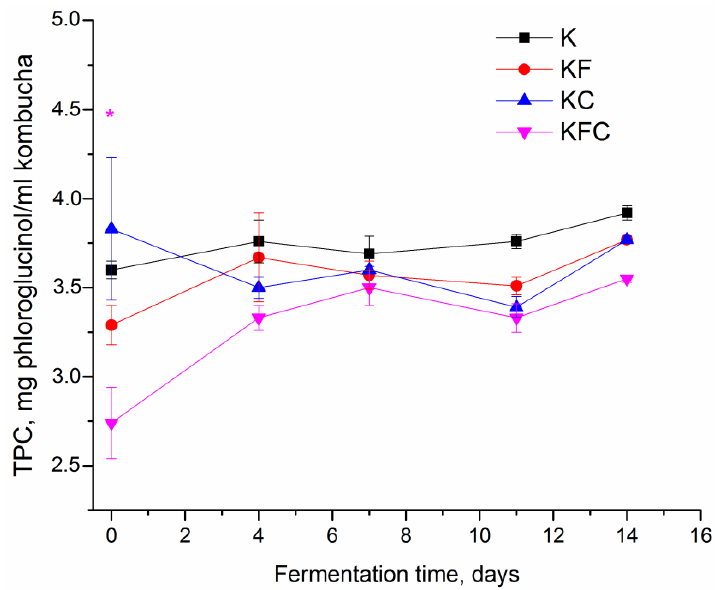
Figure 2. Total polyphenolic content (TPC) of kombucha during fermentation (K—control, KF— kombucha with algae extract, KC—kombucha with lichen extract, KFC—kombucha with a mixture of algae and lichen extracts). * Significantly different from K, p < 0.01.